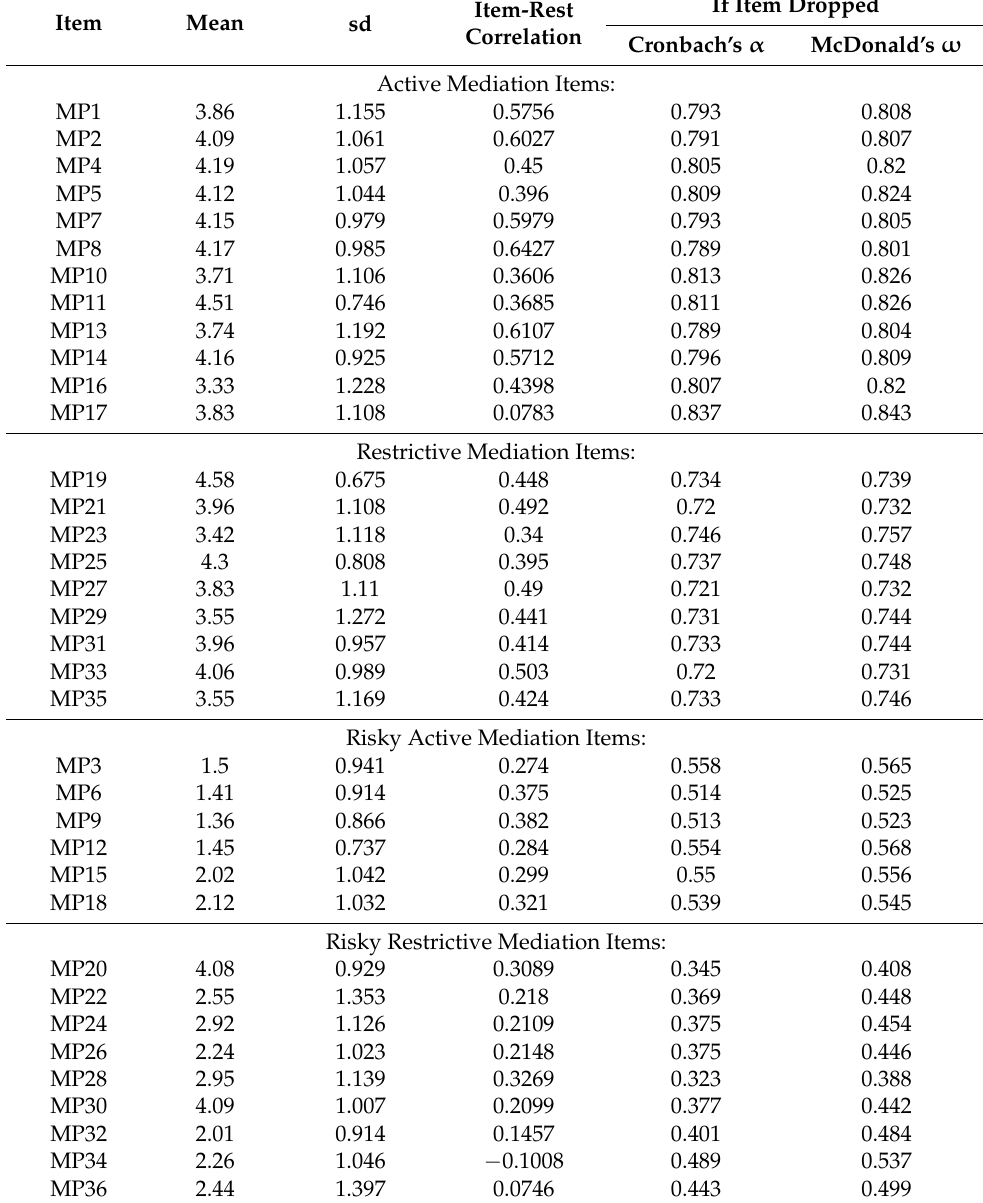
Table 2. MEPA-36 Item Reliability